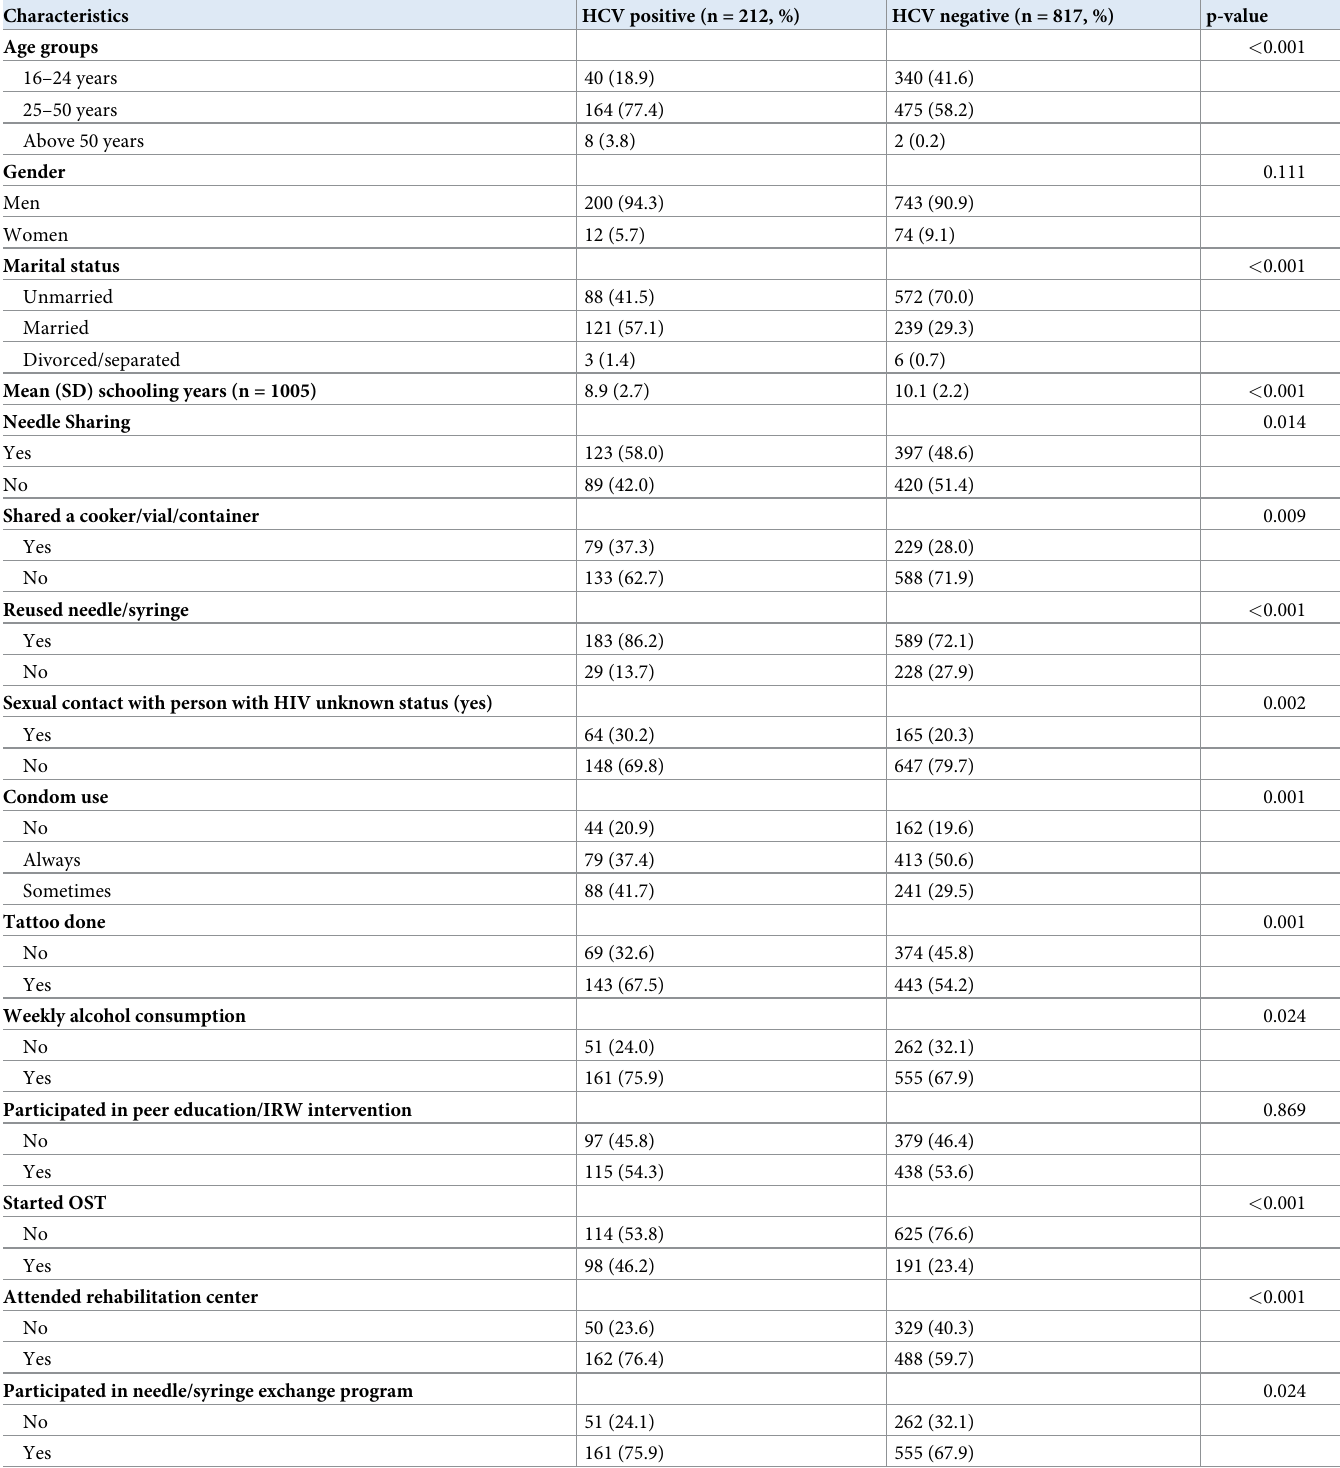
Table 4. Descriptive analysis of socio-demographic and risk characteristics on HCV screening results.